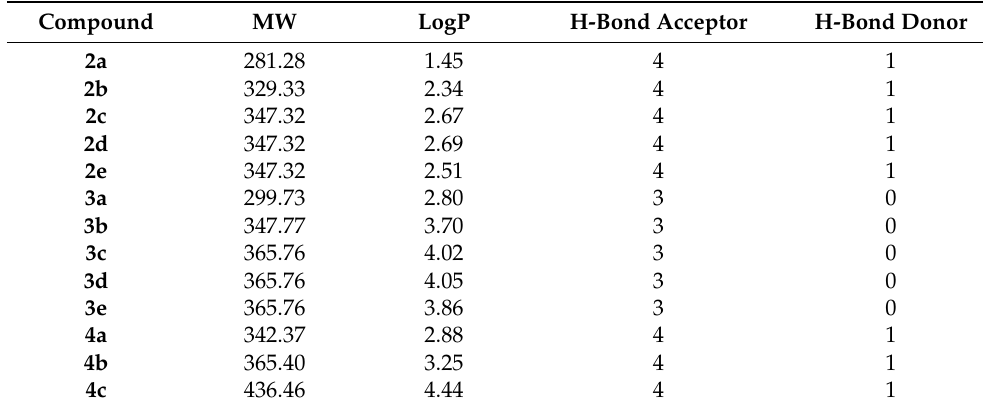
Table 1. The Lipinski-selected parameters calculated with Molinspiration 1 for compounds 2a-e , 3a-e and 4a-c